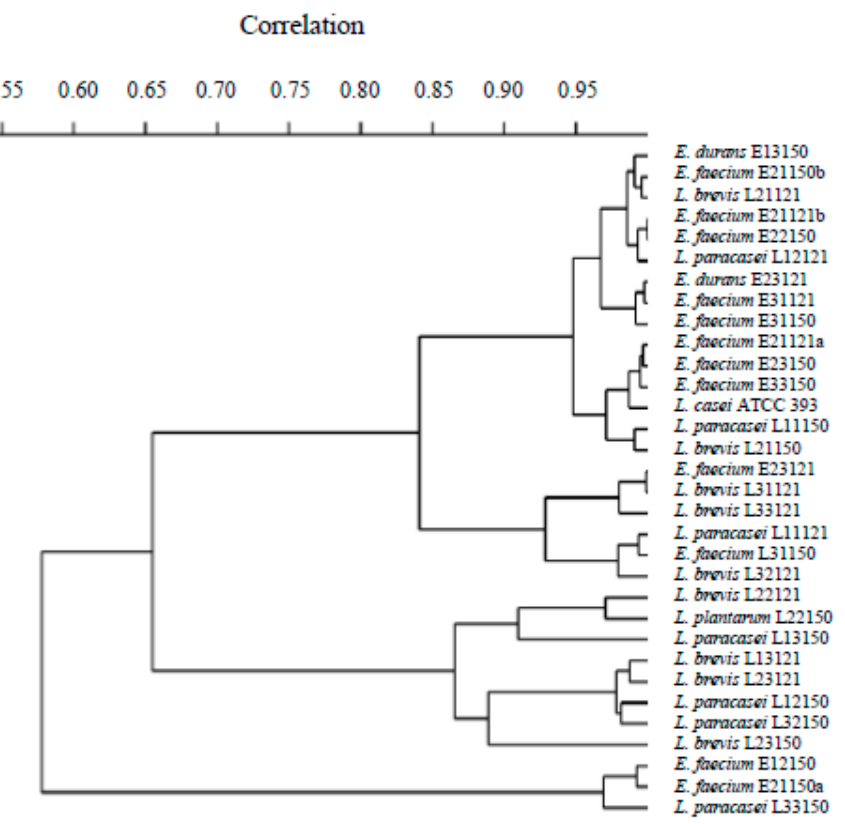
Figure 2. Correlation clustering based on average values of tolerance to low pH and bile salts and adhesion capacity reported in Table 2 for LAB isolates at 121 and 150 days.